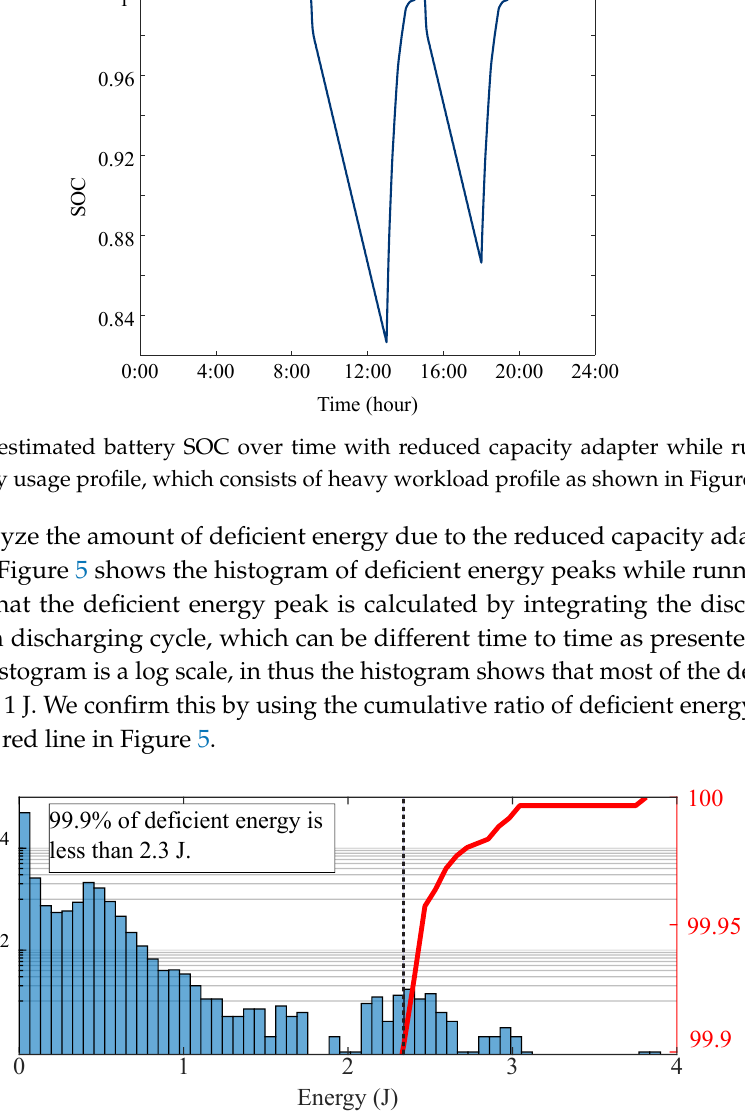
Figure 5. Histogram and the cumulative ratio of deficient energy peaks when running the workload for